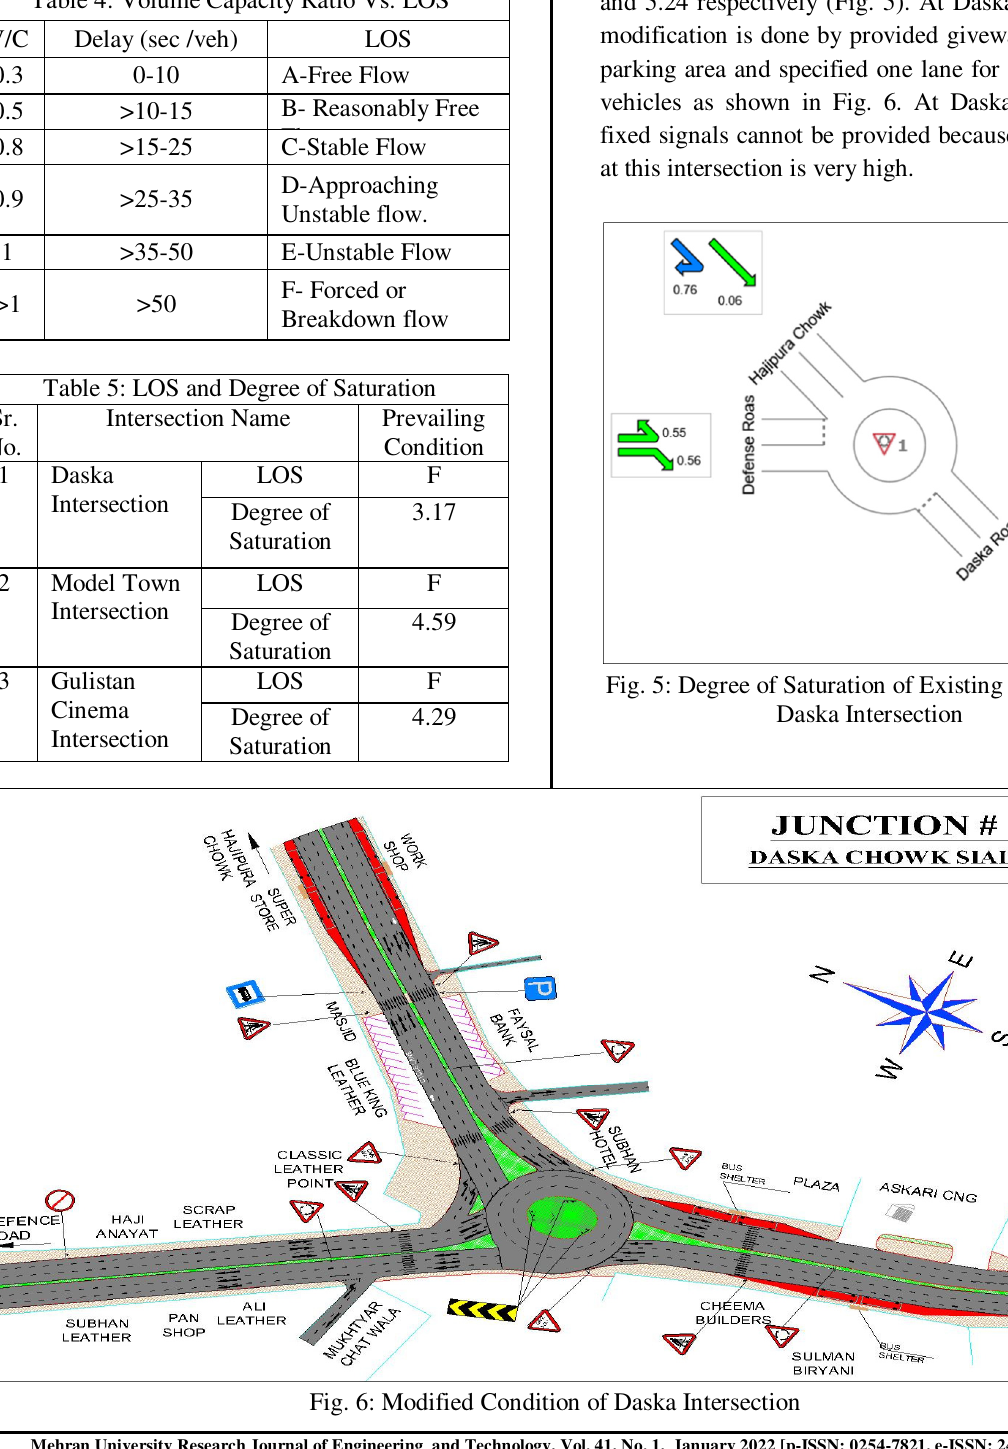
Table 4: Volume Capacity Ratio Vs.